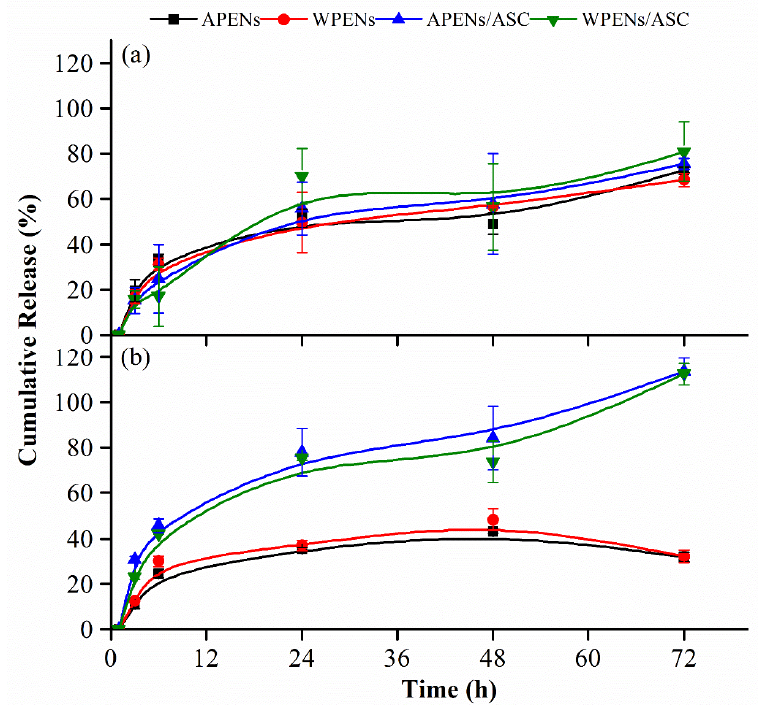
Figure 7. In vitro release profiles of RIF-loaded PENs in different release media at pH values of 7.4 ( a ) and 8.5 ( b ) in the presence and absence of ASC.